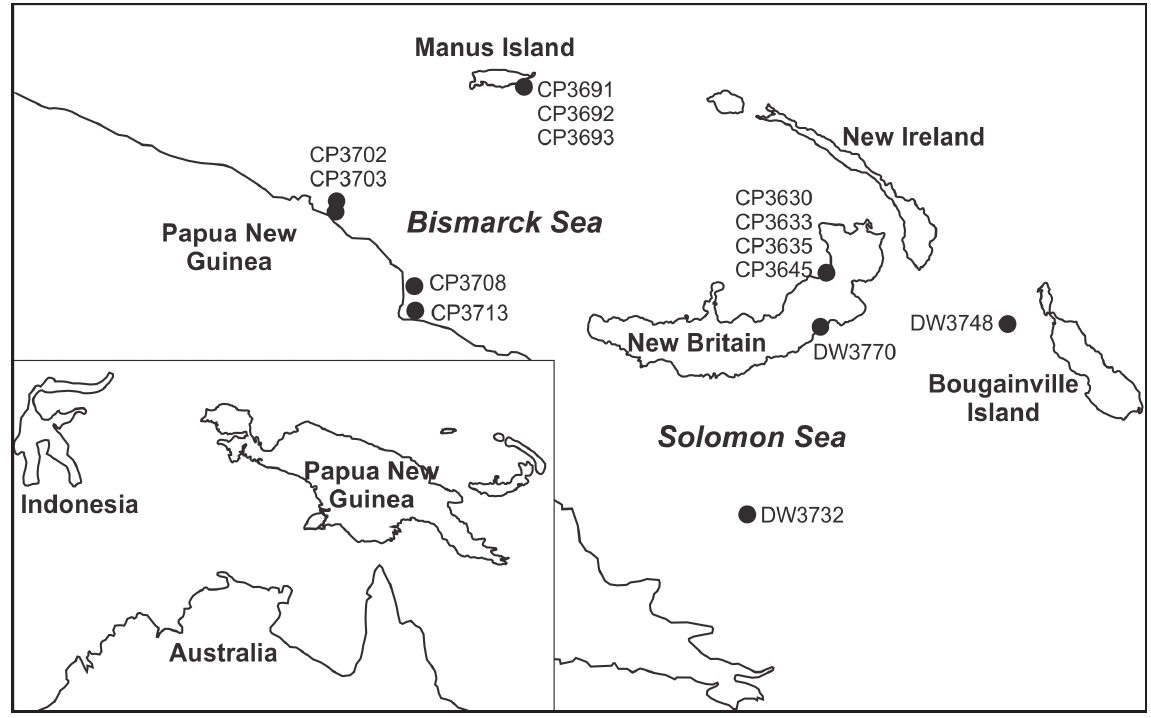
Fig. 1. Map of Papua New Guinea with stations cited in this